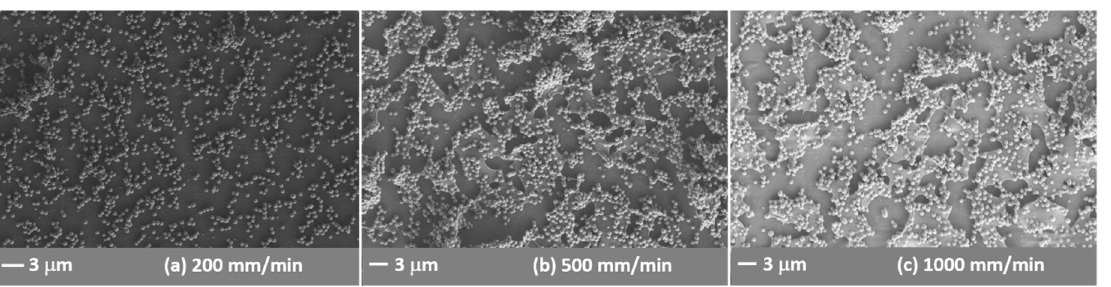
Figure 6. SEM images of hydrophobic silica coatings dipped for 5 min four times, and aged for 5 days with a dipping rate of ( a ) 200 mm/min, ( b ) 500 mm/min and ( c ) 1000 mm/min.